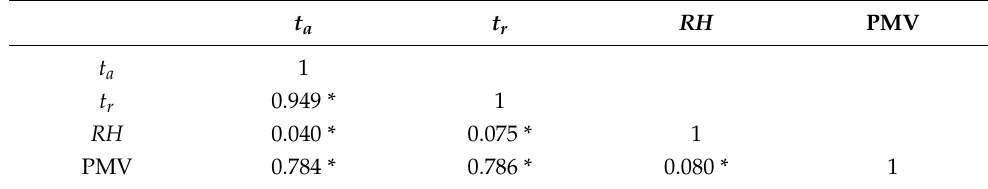
Table 2. Descriptive statistics and correlation analysis of four variables (N = 30734, * p < 0.01).